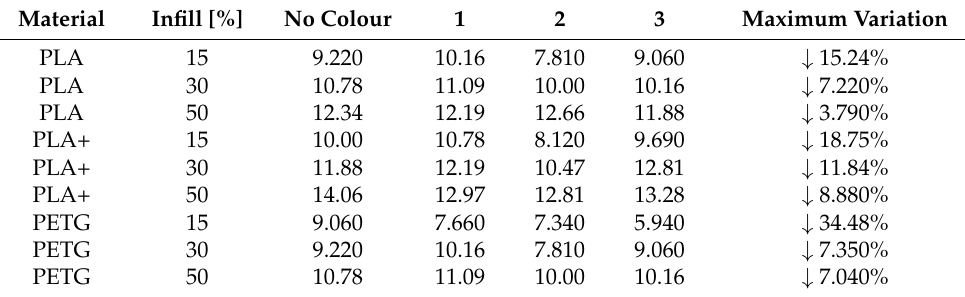
Table 6. Uncoloured test values/tensile strength.